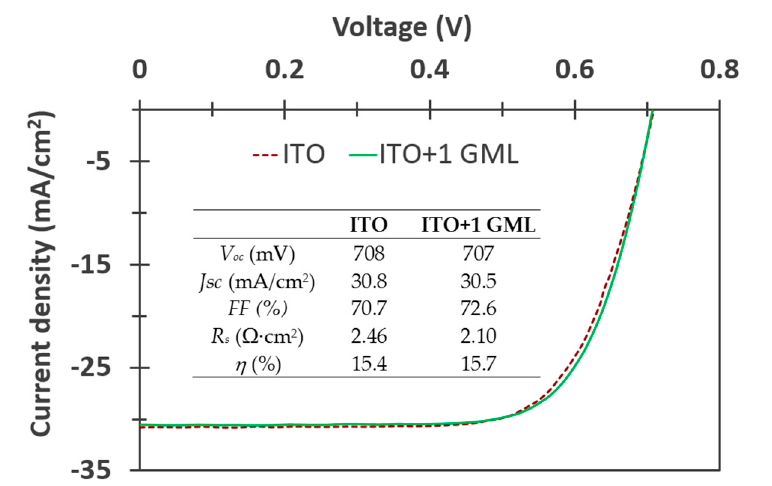
Figure 7. JV characteristics under illumination of the cells with either ITO as the front TCE and with the ITO layer covered with one graphene